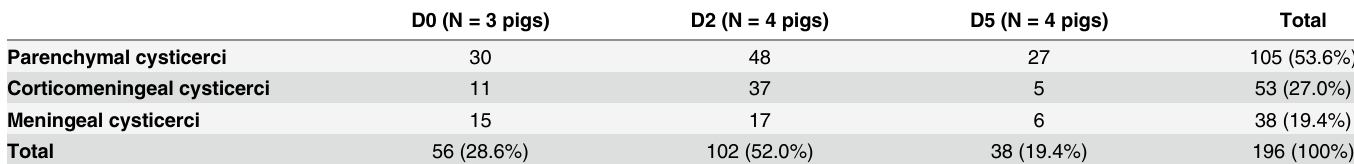
Table 1. Cysticercal location according to treatment